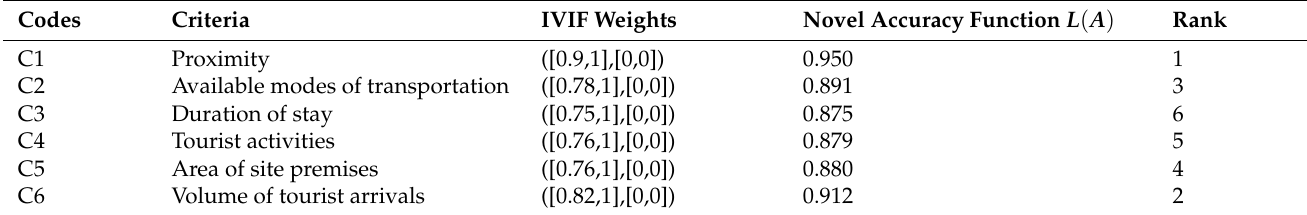
Table 3. The IVIF weights of the evaluation criteria of tourist